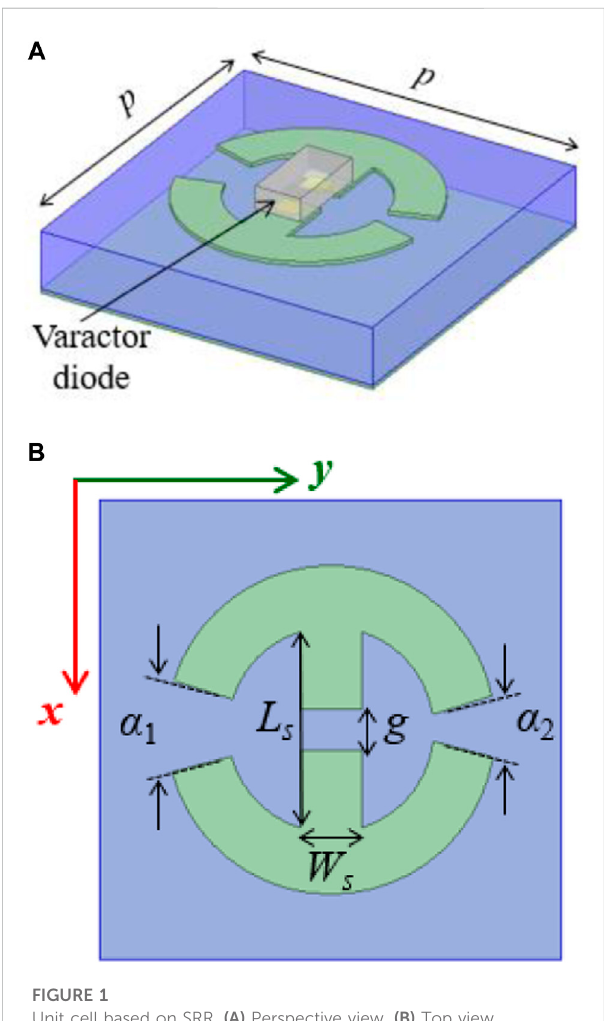
FIGURE 1 Unit cell based on SRR. (A) Perspective view. (B) Top view.